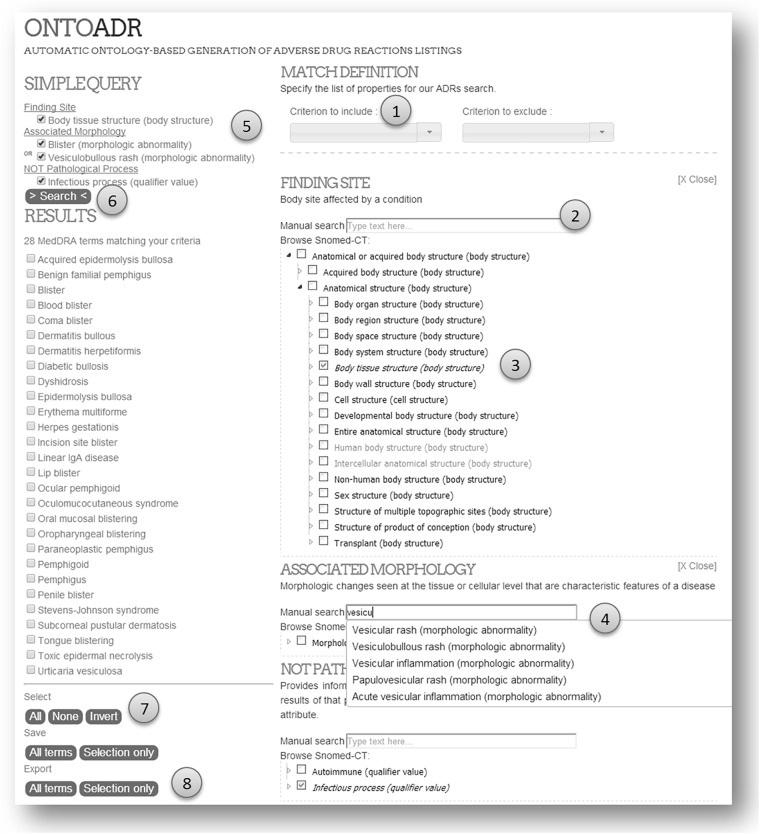
Screenshot of the OntoADR Query Tools interface.